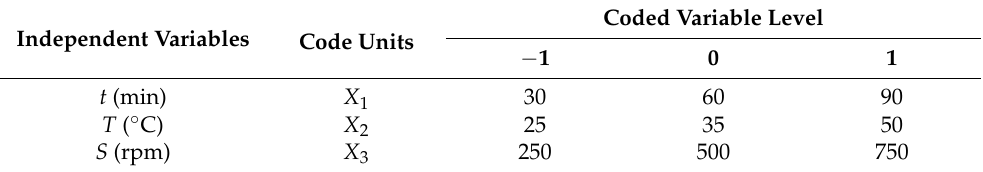
Table 2. Independent variables and their related actual and coded levels utilized to optimize the extraction of